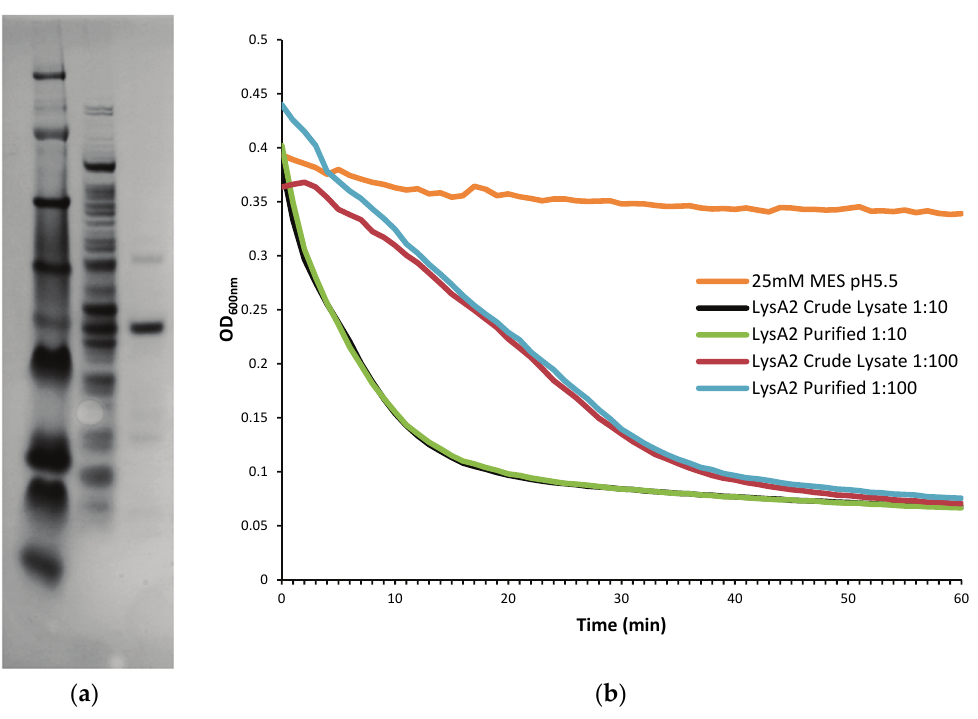
Figure 4. ( A ) Purification of LysA2 (37.4 kDa) by anion exchange. SDS-PAGE gel for Figure 4. ( a ) Purification of LysA2 (37.4 kDa) by anion exchange. SDS-PAGE gel for purified LysA2 purified LysA2 samples that had been diluted 10-fold Lanes 1—See Blue Plus2 Protein Ladder; samples that had been diluted 10-fold Lanes 1—See Blue Plus2 Protein Ladder; Lanes 2—LysA2 crude Lanes 2—LysA2 crude lysate; Lanes 3—Purified LysA2; ( B ) Ten- and 100-fold diluted purified lysate; Lanes 3—Purified LysA2; ( b ) Ten- and 100-fold diluted purified LysA2 and crude lysate in a LysA2 and crude lysate in a turbidometric reduction assay against L. jensenii . Activity of the purified turbidometric reduction assay against L. jensenii . Activity of the purified and crude LysA2 display the and crude LysA2 display the same kinetics for both dilutions tested. same kinetics for both dilutions